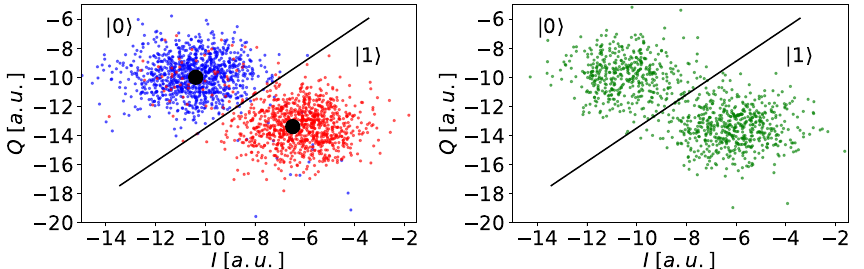
Figure 1. (Color online). Left panel. Example of data distribution associated to the measurements of the state | 0 (cid:105) (blue dots) and | 1 (cid:105) (red dots) in the ( I , Q ) plane (in arbitrary units) of the Armonk single-qubit device. Big black dots indicate the centers of the two distributions, while the black line separates them. Notice that despite the distortion due to the aspect ratio of the plot, this line is perpendicular to the segment connecting the two centers. The efficiency of the considered separation is roughly 97.4% for the ground state and 92.7% for the excited state. Right panel. Example of a distribution associated to the measurement of a state with θ = π /2 (green dots). The distribution presents now two separated lobes, one in each sector. The energy stored in the system is related to the fraction of the dots composing the lobe in the | 1 (cid:105) sector with respect to the total runs. In the present case, this is given by P 1 ≈ 0.567. For each state shown in the plot, we have considered 1024